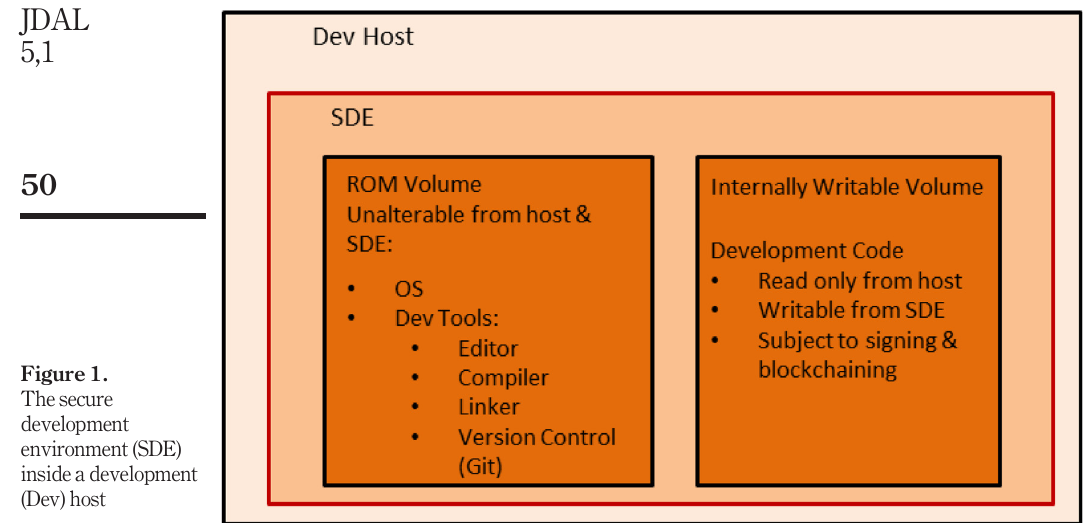
Figure 1. The secure development environment (SDE) inside a development (Dev)